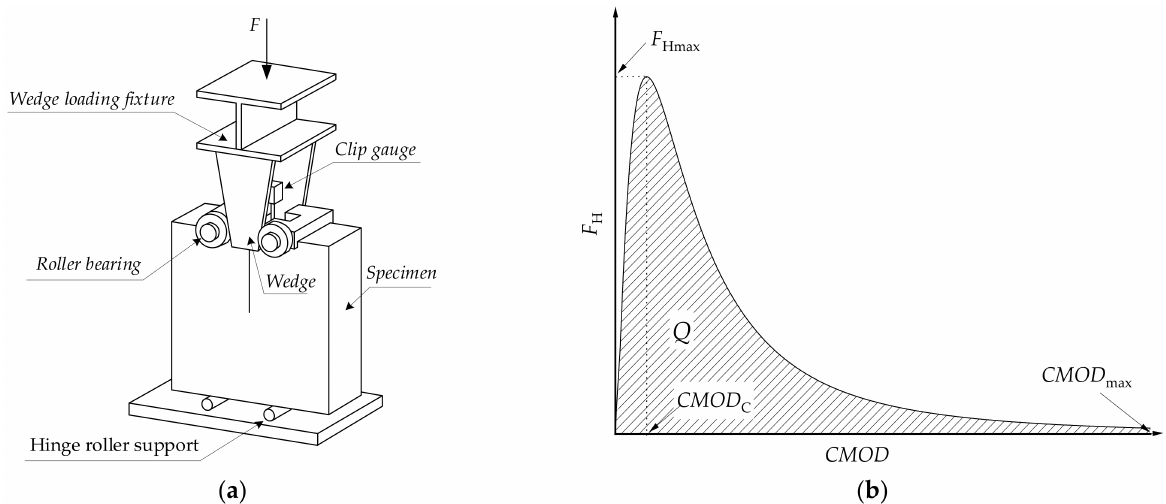
Figure 6. Wedge-splitting fracture test: ( a ) diagram of the loading device and ( b ) schematic diagram of the F H - CMOD